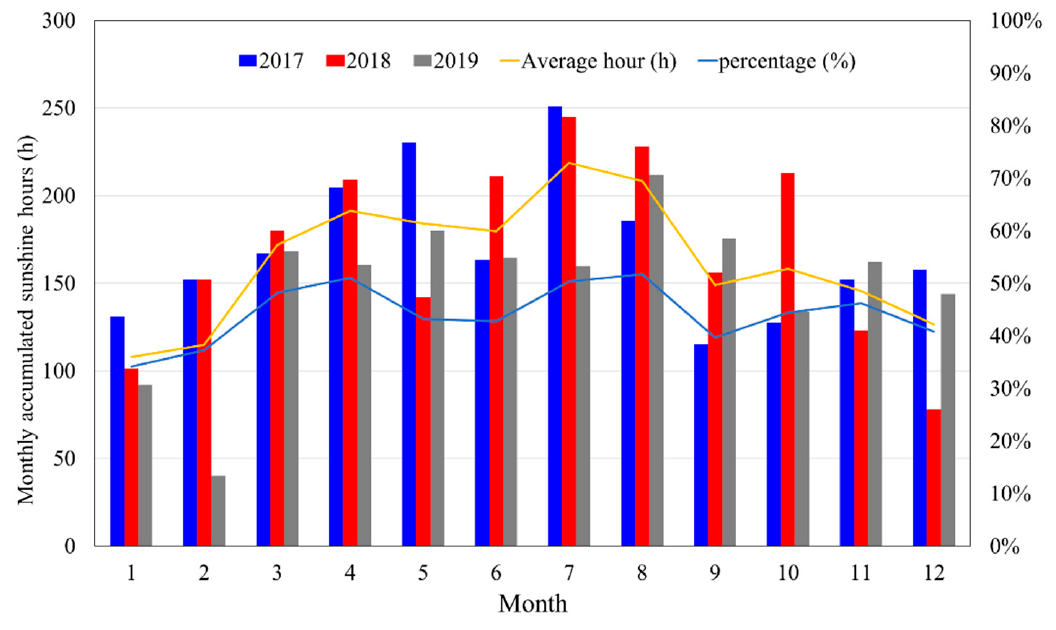
Figure 5. Monthly accumulated sunshine hours and sunshine percentage in Nanjing city, based on recorded data from 2017 to 2019.